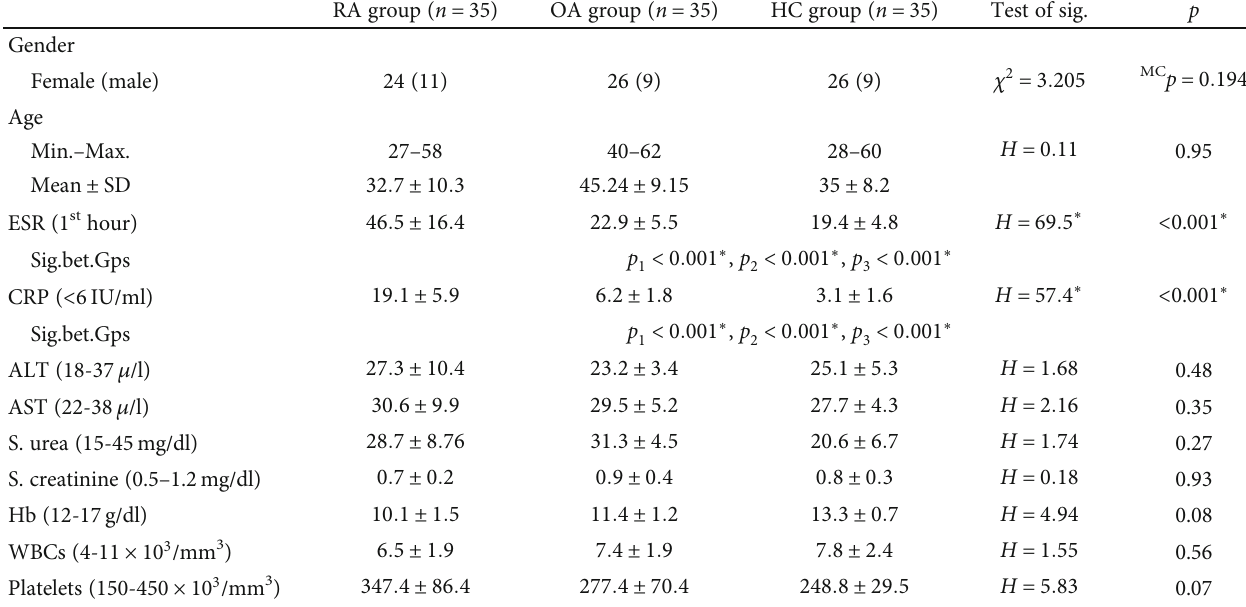
Table 1: Characteristics of participants.